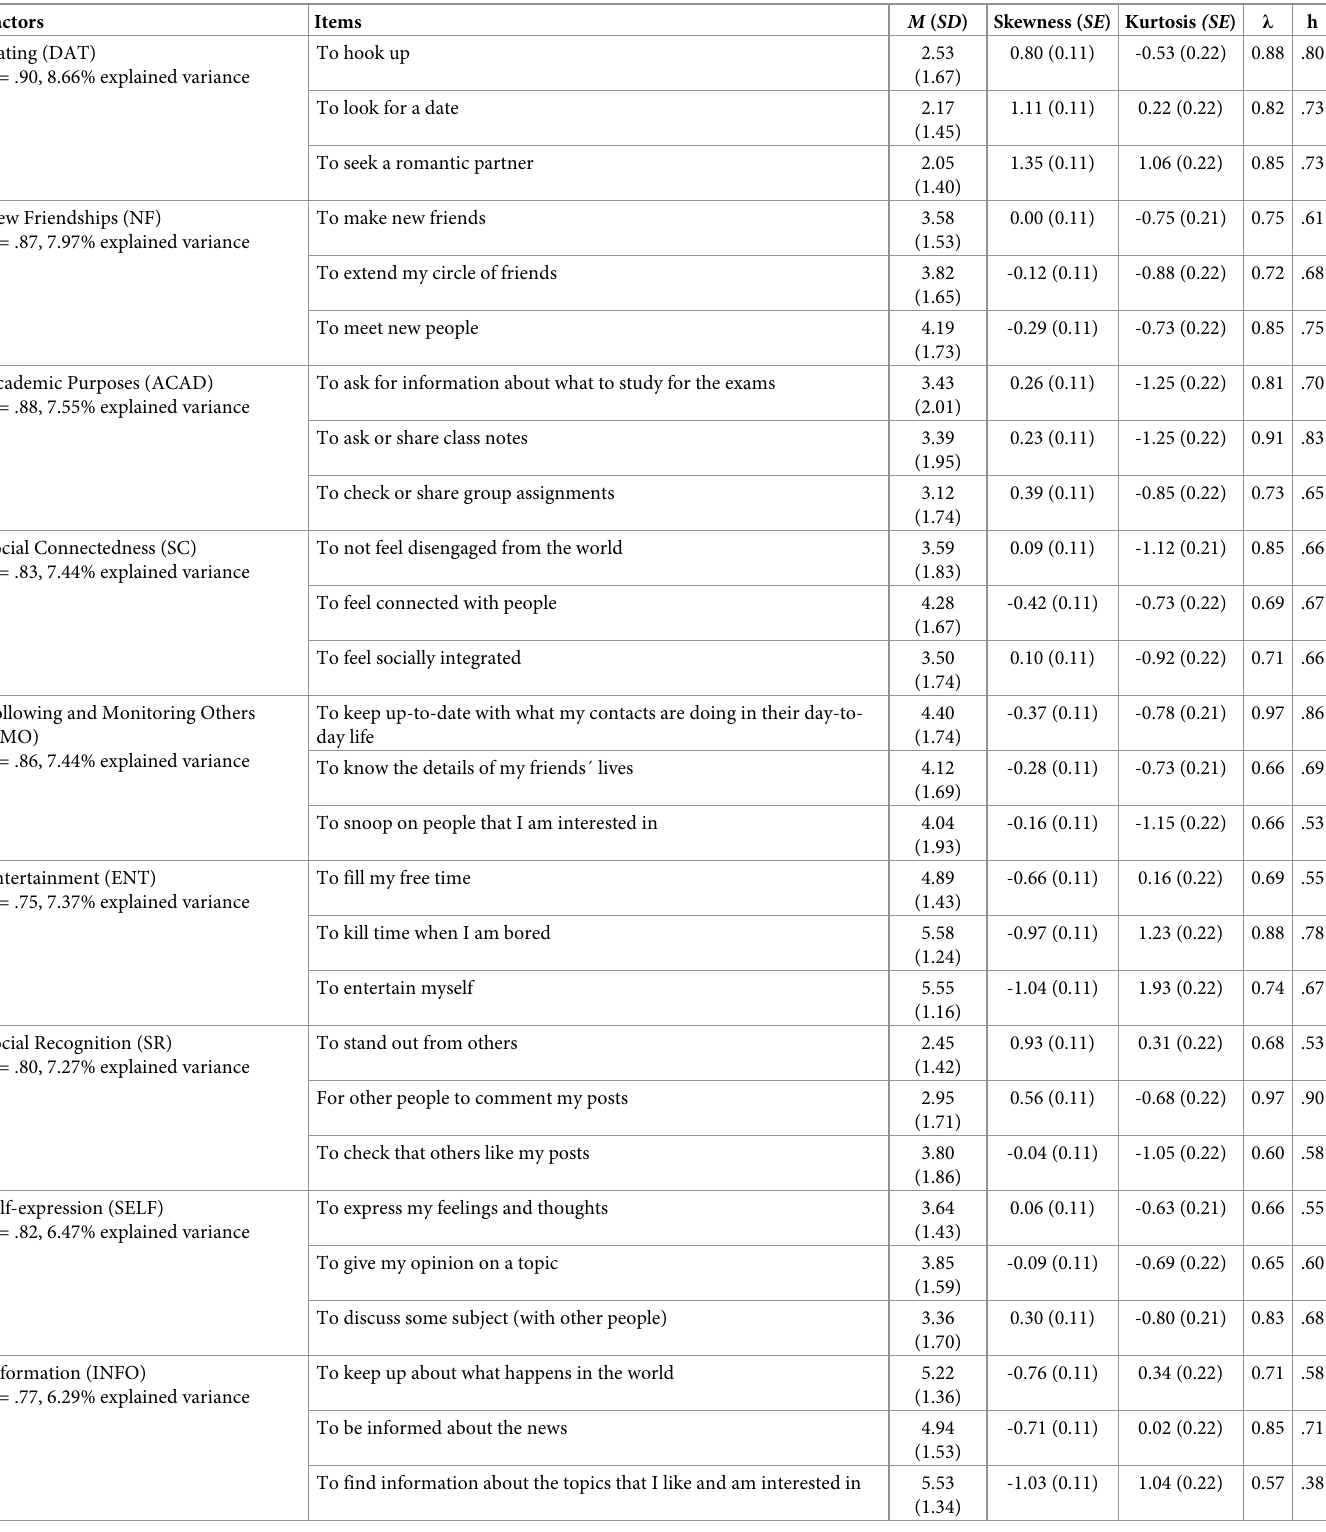
Table 5. EFA for the final 27-item, item descriptive statistics and factor loadings.